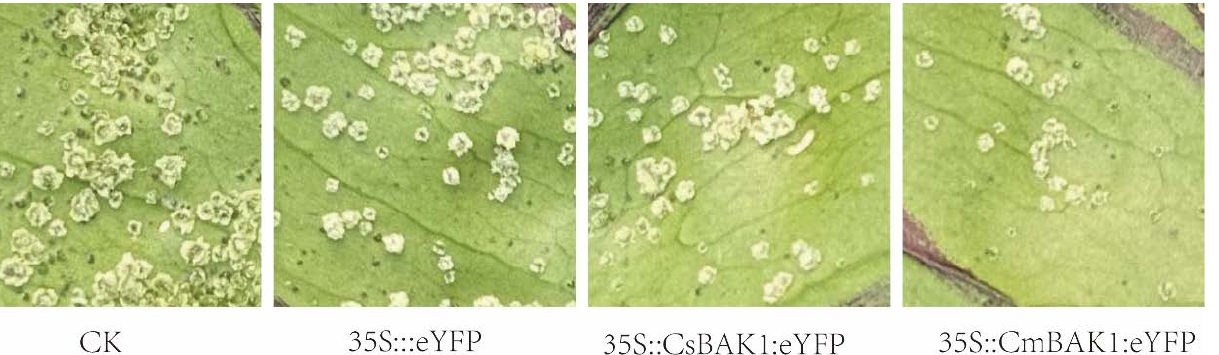
Figure 5. Leaf symptoms after transient expression of BAK1. CK: control injected with buffer solu-